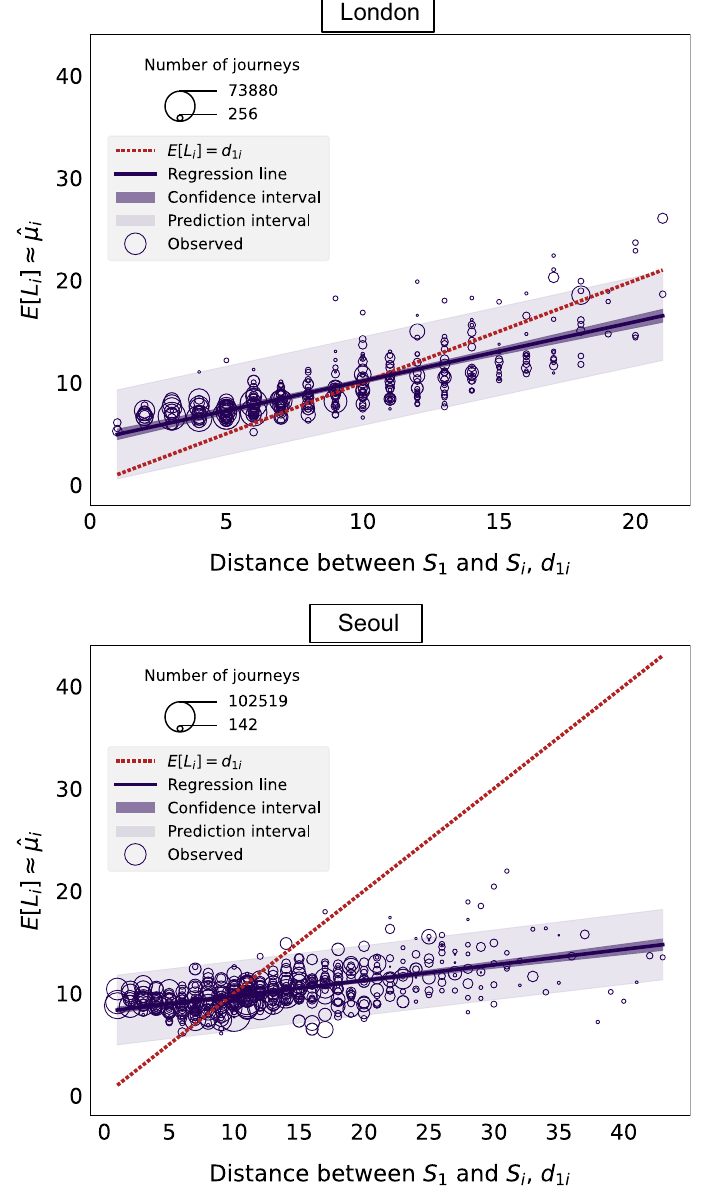
p ˆ µ d i and i ,